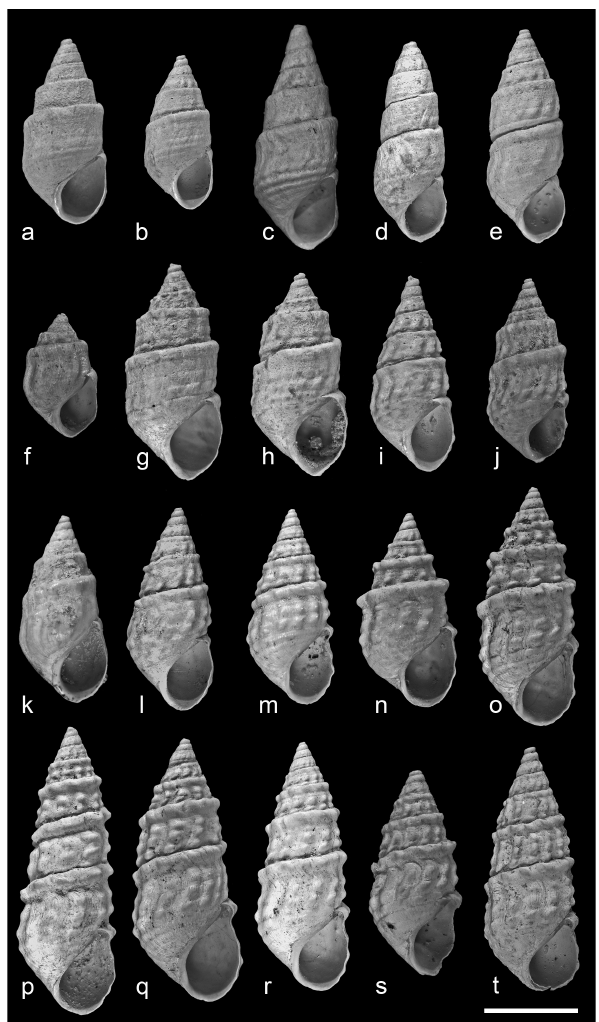
Fig. 6. Melanoides specimens from the Chipalamawamba Beds. The first two rows represent material from Unit 1, with much weaker ornamentation than specimens from Units 2 and 3 (lower two rows). In Unit 1, M. cf. polymorpha (A–C) is very abundant, and M . cf. nyassana (D) occurs regularly too. Specimens of M. pupiformis (E) and of M. cf. turritispira (F–J) are not that abun-